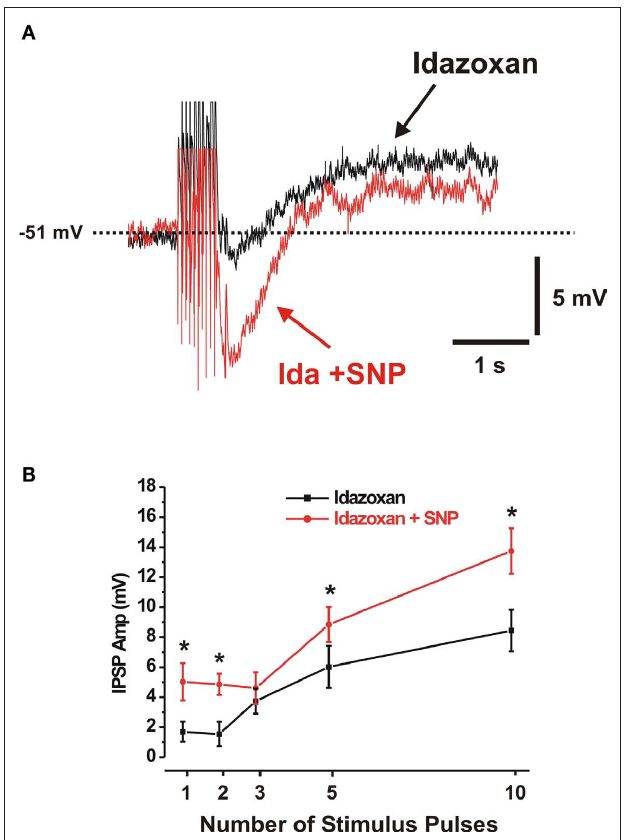
FIgurE 4 | Sodium nitroprusside enhances non-adrenergic IPSPs. (A) Ten-pulse non-adrenergic IPSP (idazoxan present, black control, red in SNP and idazoxan). (B) Quantitative data showing the effects of SNP (red line) on the amplitudes of 1-, 2-, 3-, 5- and 10-pulse non-adrenergic IPSPs. * P < 0.05.